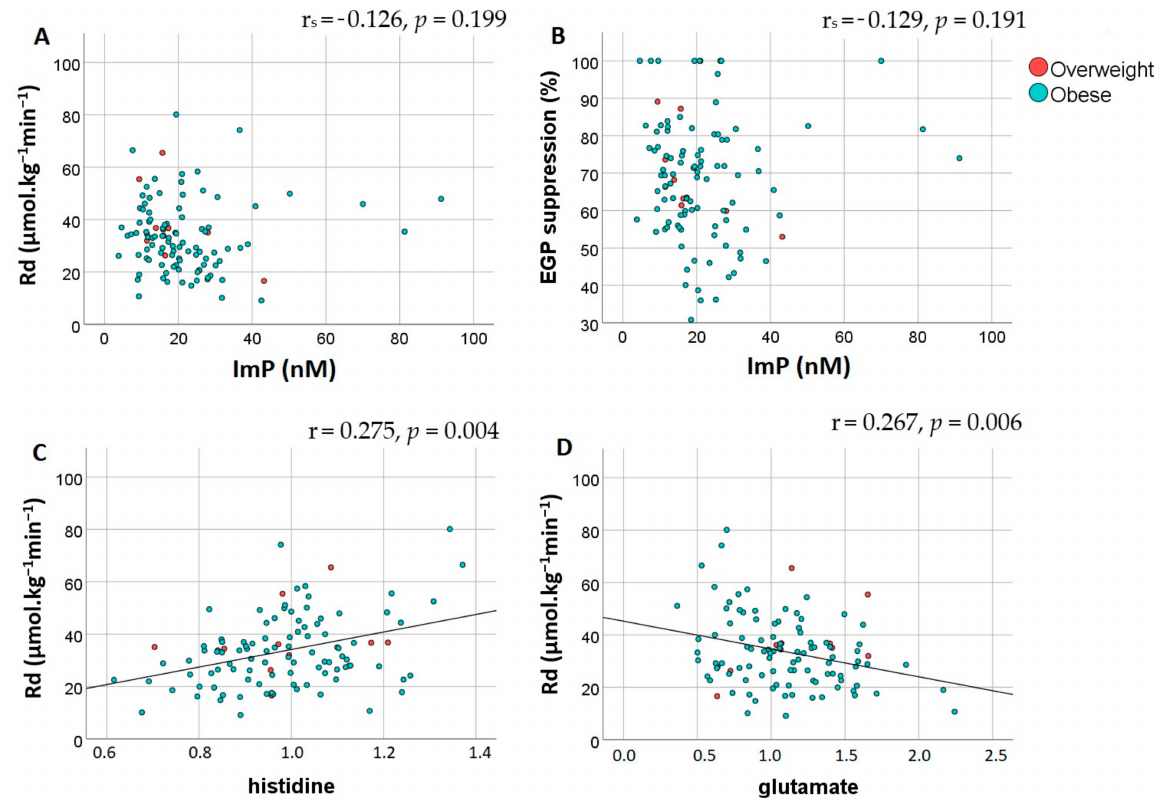
Figure 2. Peripheral and hepatic insulin sensitivity are not associated with imidazole propionate but do correlate with histidine and glutamate. Spearman partial correlation analysis adjusted for BMI and age showed an absence of corre- lation between plasma imidazole propionate concentrations (nM) and ( A ) peripheral insulin resistance assessed by Rd ( µ mol · kg − 1 min − 1 ) and ( B ) hepatic insulin resistance assessed by EGP suppression (%). Pearson correlation indicated that there was a significant correlation between Rd and ( C ) plasma histidine levels and ( D ) plasma glutamate levels. Red dots represent overweight subjects while blue dots represent subjects with obesity. Abbreviations: Rd, rate of disposal; EGP, endogenous glucose production; ImP, imidazole